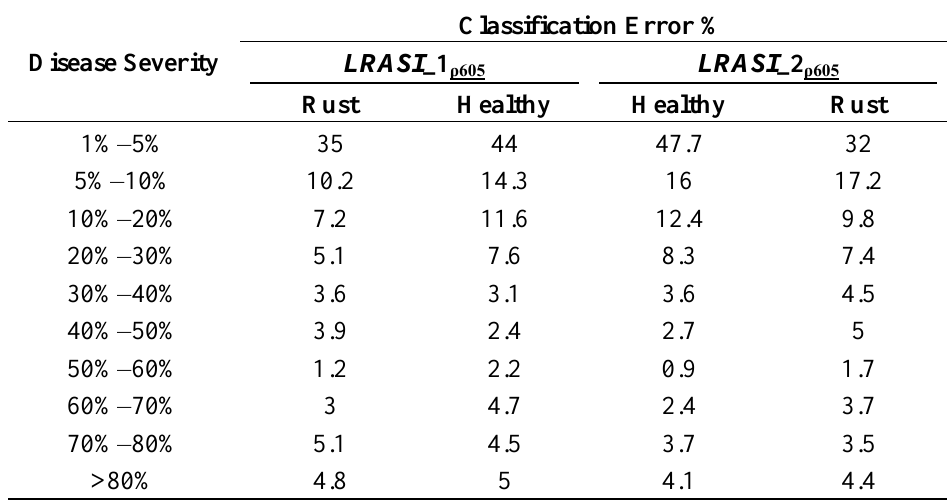
Table 3. Classification error for the healthy and infected classes using LRDSI